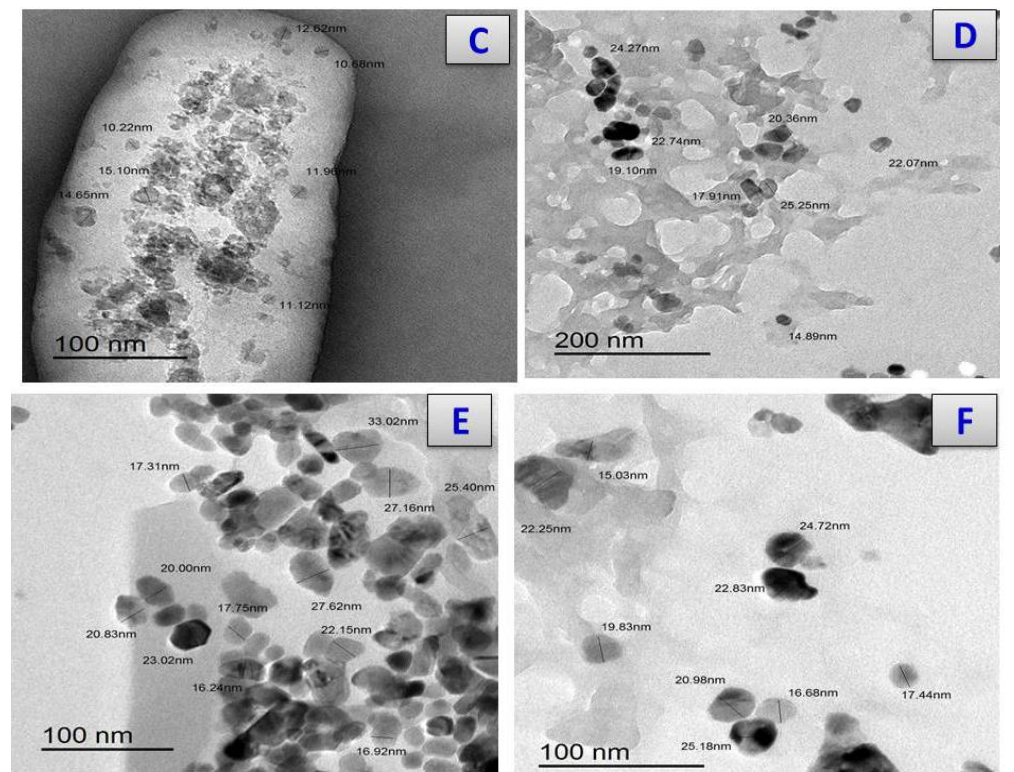
Figure 7. TEM images of ( A ) Cfotax, ( B ) cefotax/Ca, ( C ) cefotax/Cr, ( D ) cefotax/Cu, ( E ) cefotax/Zn, and ( F ) cefotax/Se.